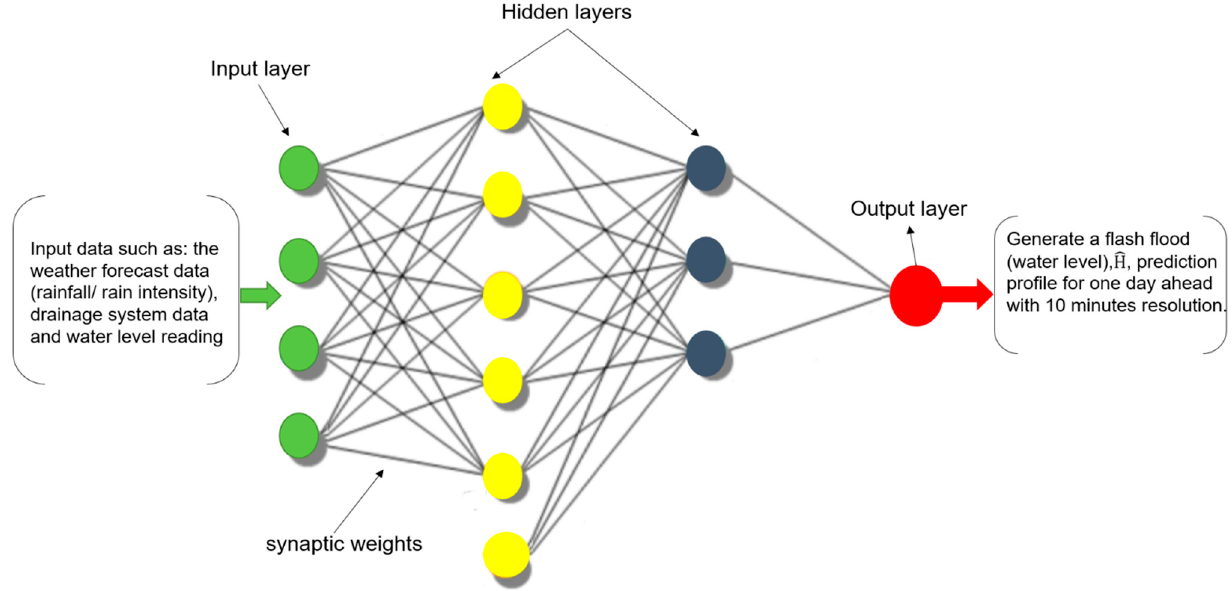
Figure 13. The basic structure of the ANN forecast model for EFWS.